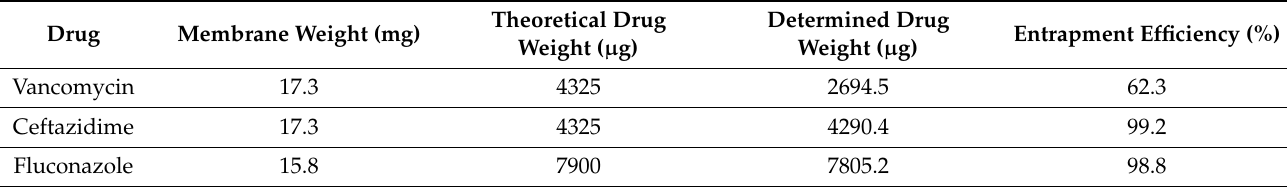
Figure 5. Differential scanning calorimetry assay of: ( A ) pristine poly lactic- co- glycolic acid (PLGA) and vancomycin/ceftazidime-loaded PLGA nanofibers, and ( B ) pure PLGA and fluconazole-loaded PLGA nanofibers. Table 1. Entrapment efficiencies of pharmaceuticals in the nanofibers.